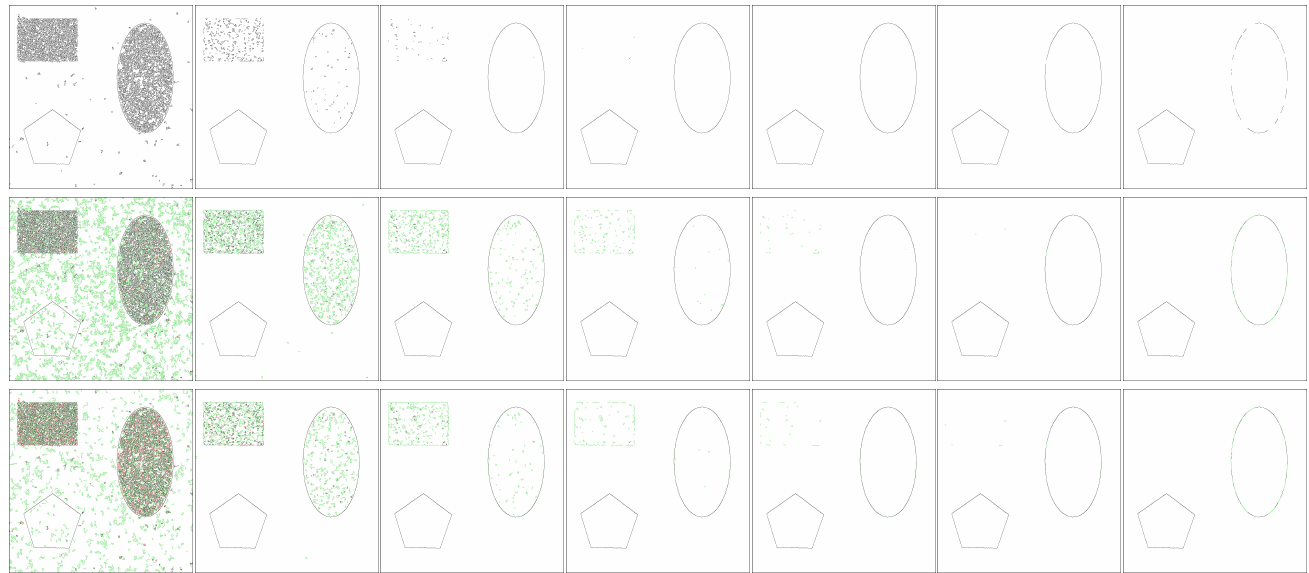
Figure 2. Example of edge map results using Canny algorithm configured with different parameters. Columns are the low and high threshold combinations used: (20, 60); (50, 90); (70, 110); (90, 130); (110, 150); (130, 170); (150, 190). Rows represent the filter used: 3 × 3 filter edge; 5 × 5 dilated filter; 7 × 7 dilated